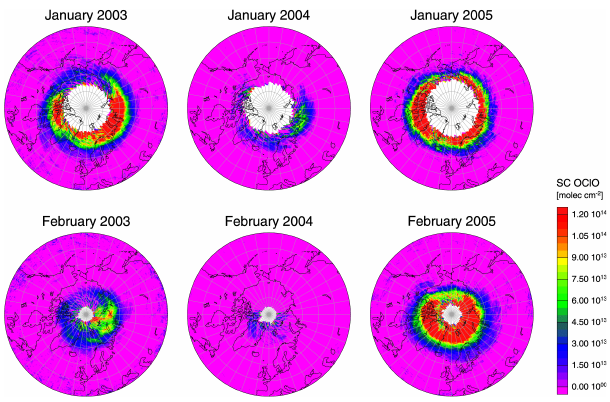
Fig. 1. Monthly averages of OClO slant column densities retrieved from SCIAMACHY observations over the Arctic for the winters 2003 to 2005, top panel shows averages for January und bottom panels for February for the three consecutive